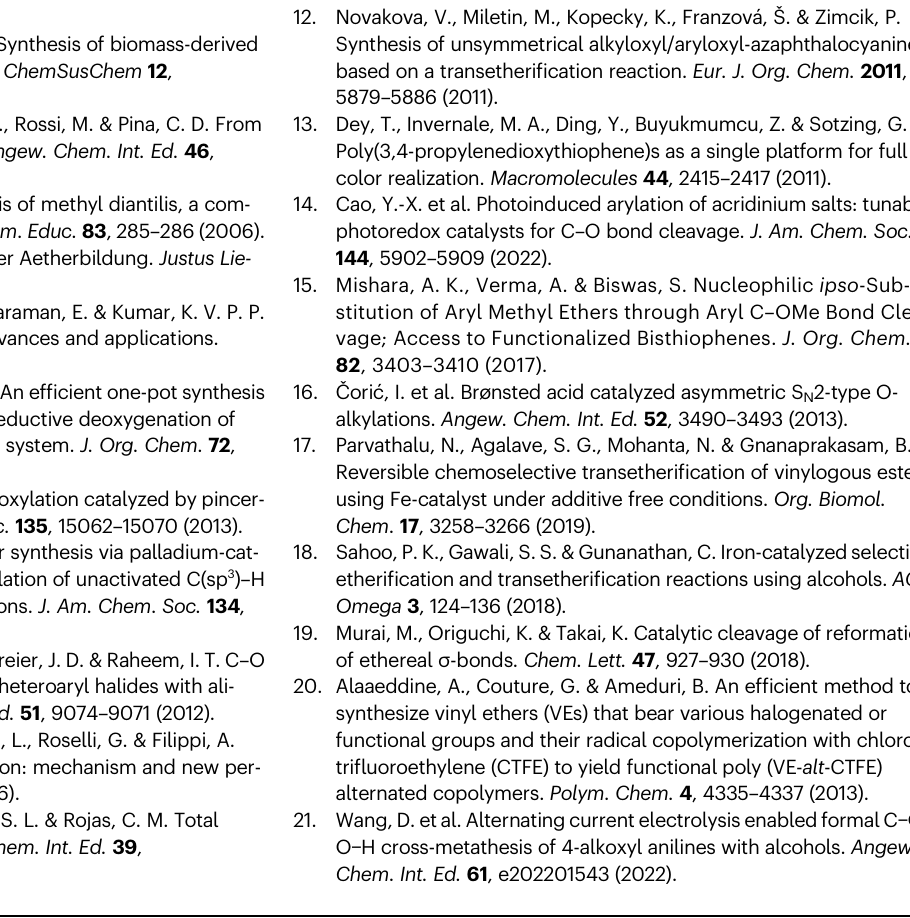
Fig.6|Ef fi ciencyimprovementbytuningthealkylgroupsofethers.a Alkylation ofsubstrateisthereasonforlowchemicalyields. b Alkylationofsubstrateisnotthe reason for low chemical yields. Yields shown in parenthesis are determined by